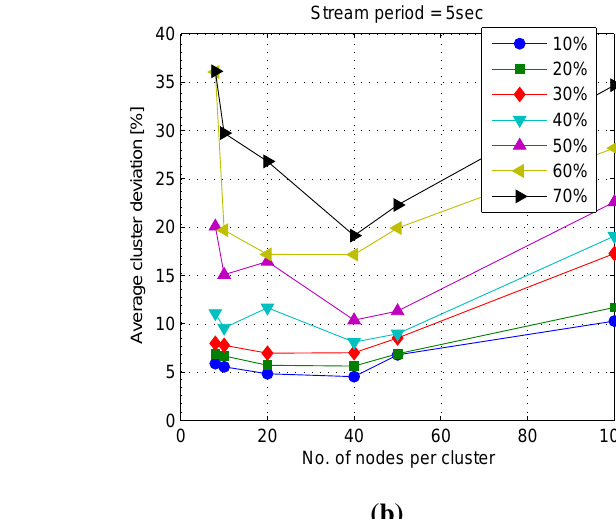
Figure 10. Average cluster deviation with varying cluster densities. ( a ) Average cluster deviation with varying cluster densities in a 1-s stream period; ( b ) average cluster deviation with varying cluster densities in a 5-s stream period.